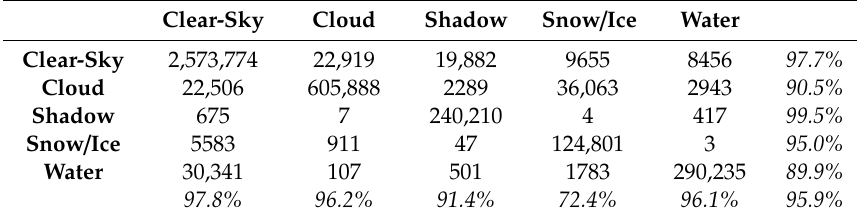
Table 3. Self-agreement across four images manually labeled twice by the same interpreter, one year apart, with class-wise agreement rates